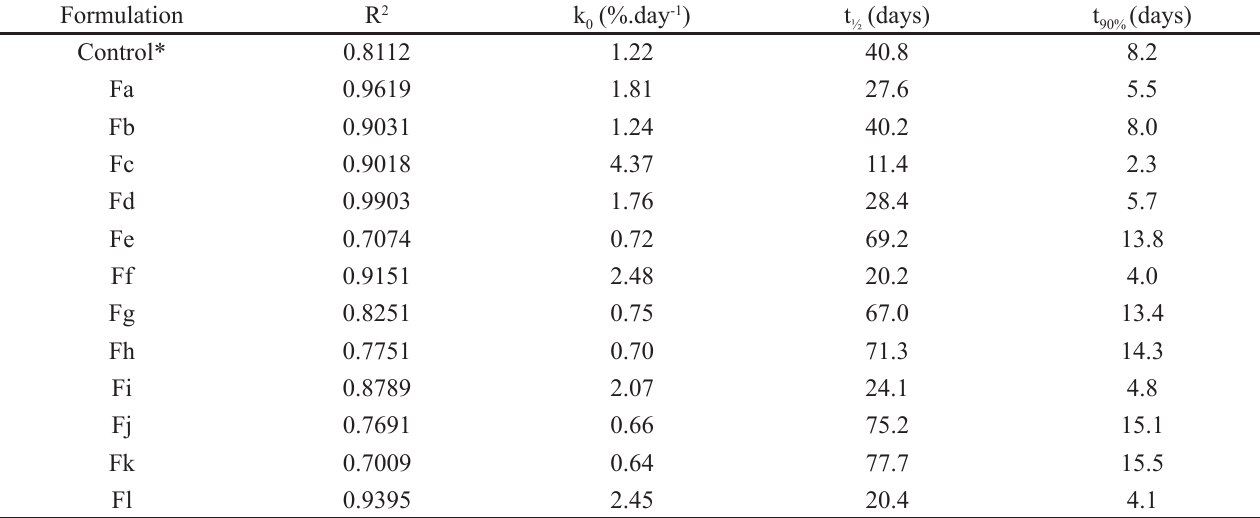
of the analyzed formulations